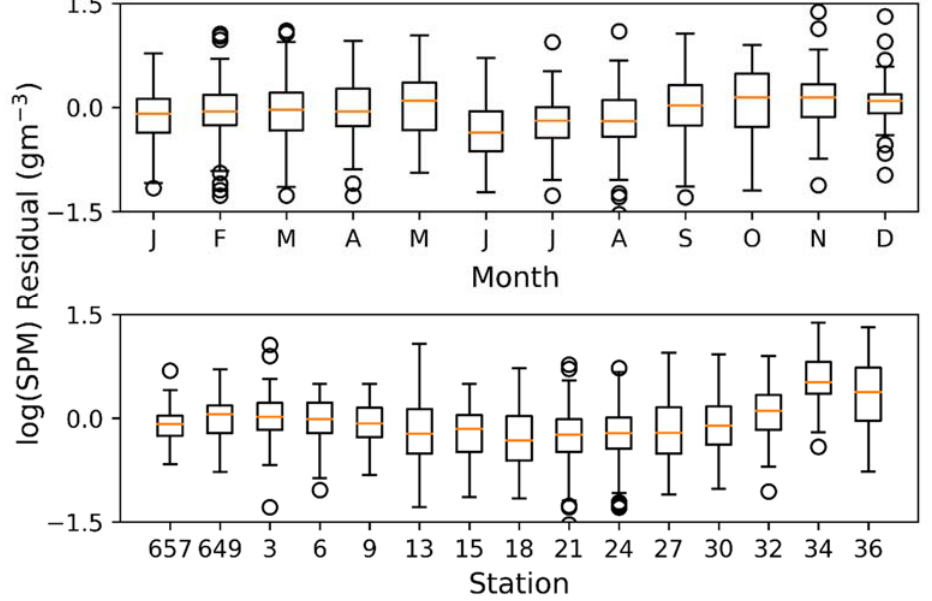
Figure 7. Box plot comparing residuals of in situ SPM (from USGS cruises) to SPM derived from MODIS AQUA using [20] with matchups as described in the Methods. Data were log 10 -transformed prior to calculating residuals. Orange lines represent median values, while lower and upper box boundaries represent the 1st and 3rd quartiles (Q1 and Q3). The upper whisker represents the highest datum less than Q3 + interquartile range (IQR) × 1.5; likewise, the lower whisker represents the lowest datum greater than Q1 − 1.5 × IQR. Open circles represent the outlying data points.